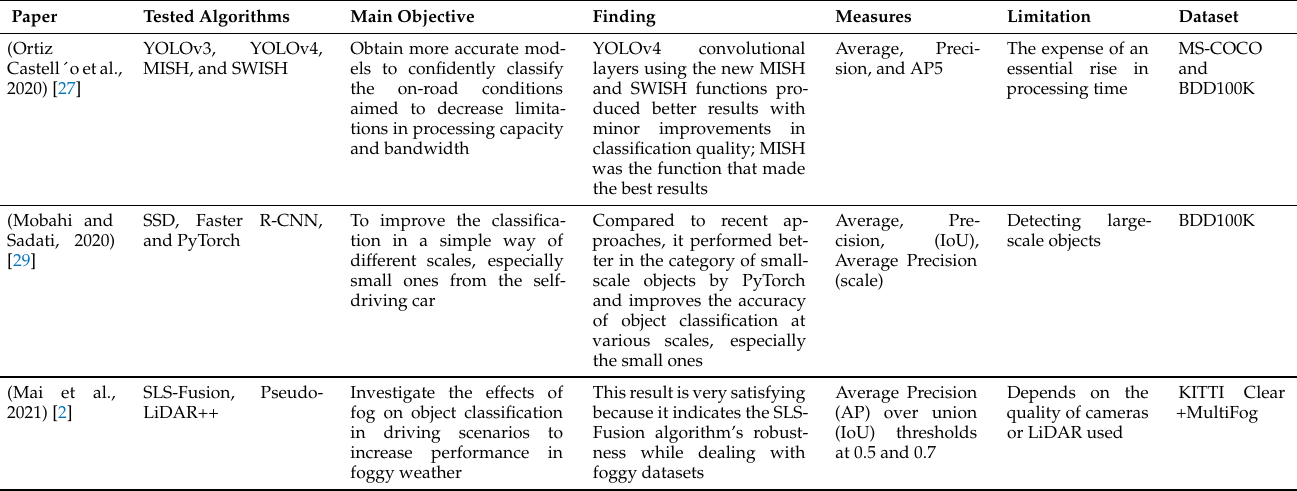
Table 1. Summary of the previous research